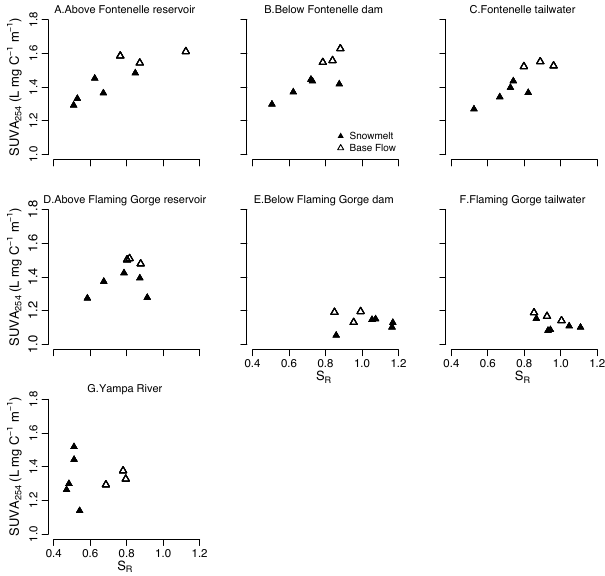
Figure 4. Mean specific ultraviolet absorbance at 254nm (SUVA 254 ,LmgC − 1 m − 1 ) plotted by the mean slope ratio ( S R ) across sampling dates for each site during snowmelt and base flow conditions. Higher SUVA 254 and lower S R indicate greater aromaticity and higher-molecular-weight DOC compared to lower SUVA 254 and higher S R , which indicate lower aromaticity and lower molecular weight of DOC. Letters A–G preceding the site names correspond to sites A–G in Fig.